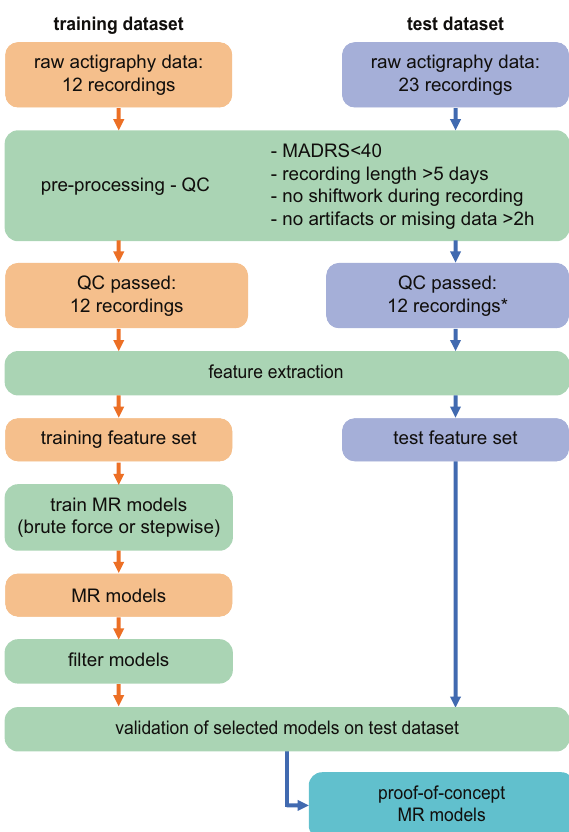
Fig. 1 Work fl ow for data analysis. All recordings were screened by the same investigator, blind torecording conditions. MR - multiple regression; * - see main text for details on reasons to not pass